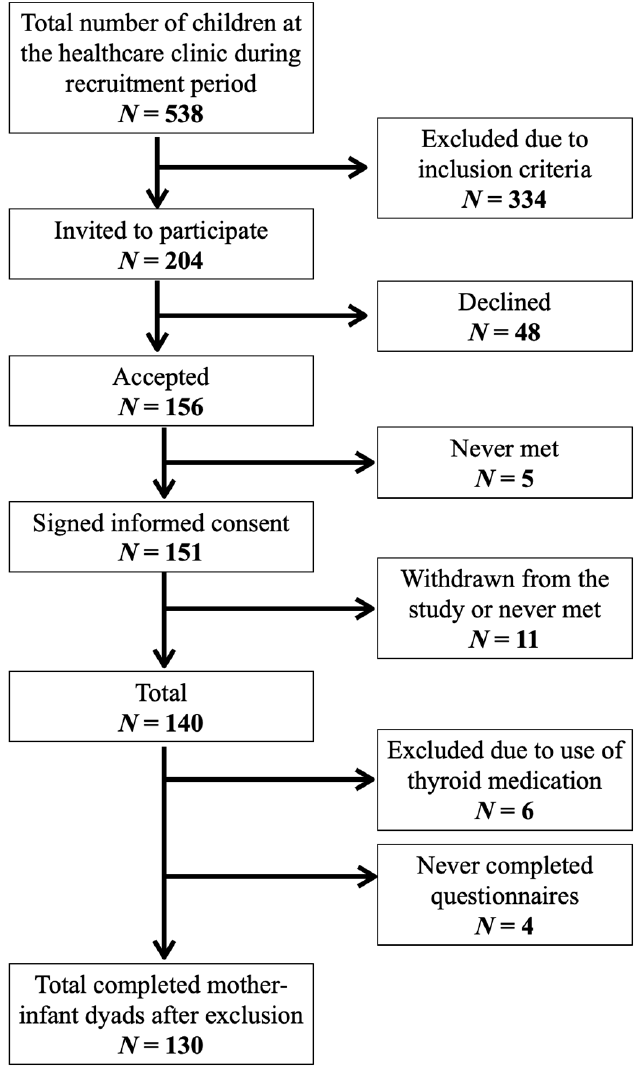
Figure 1. Flowchart of study recruitment and completion.